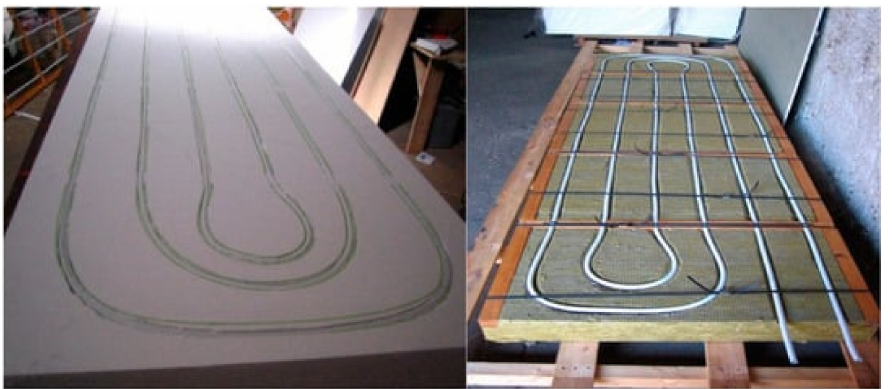
Figure 14. View of prototypes of insulation panels with integrated active thermal protection, on the left made of polystyrene, on the right of mineral wool. [Author: Kal ú